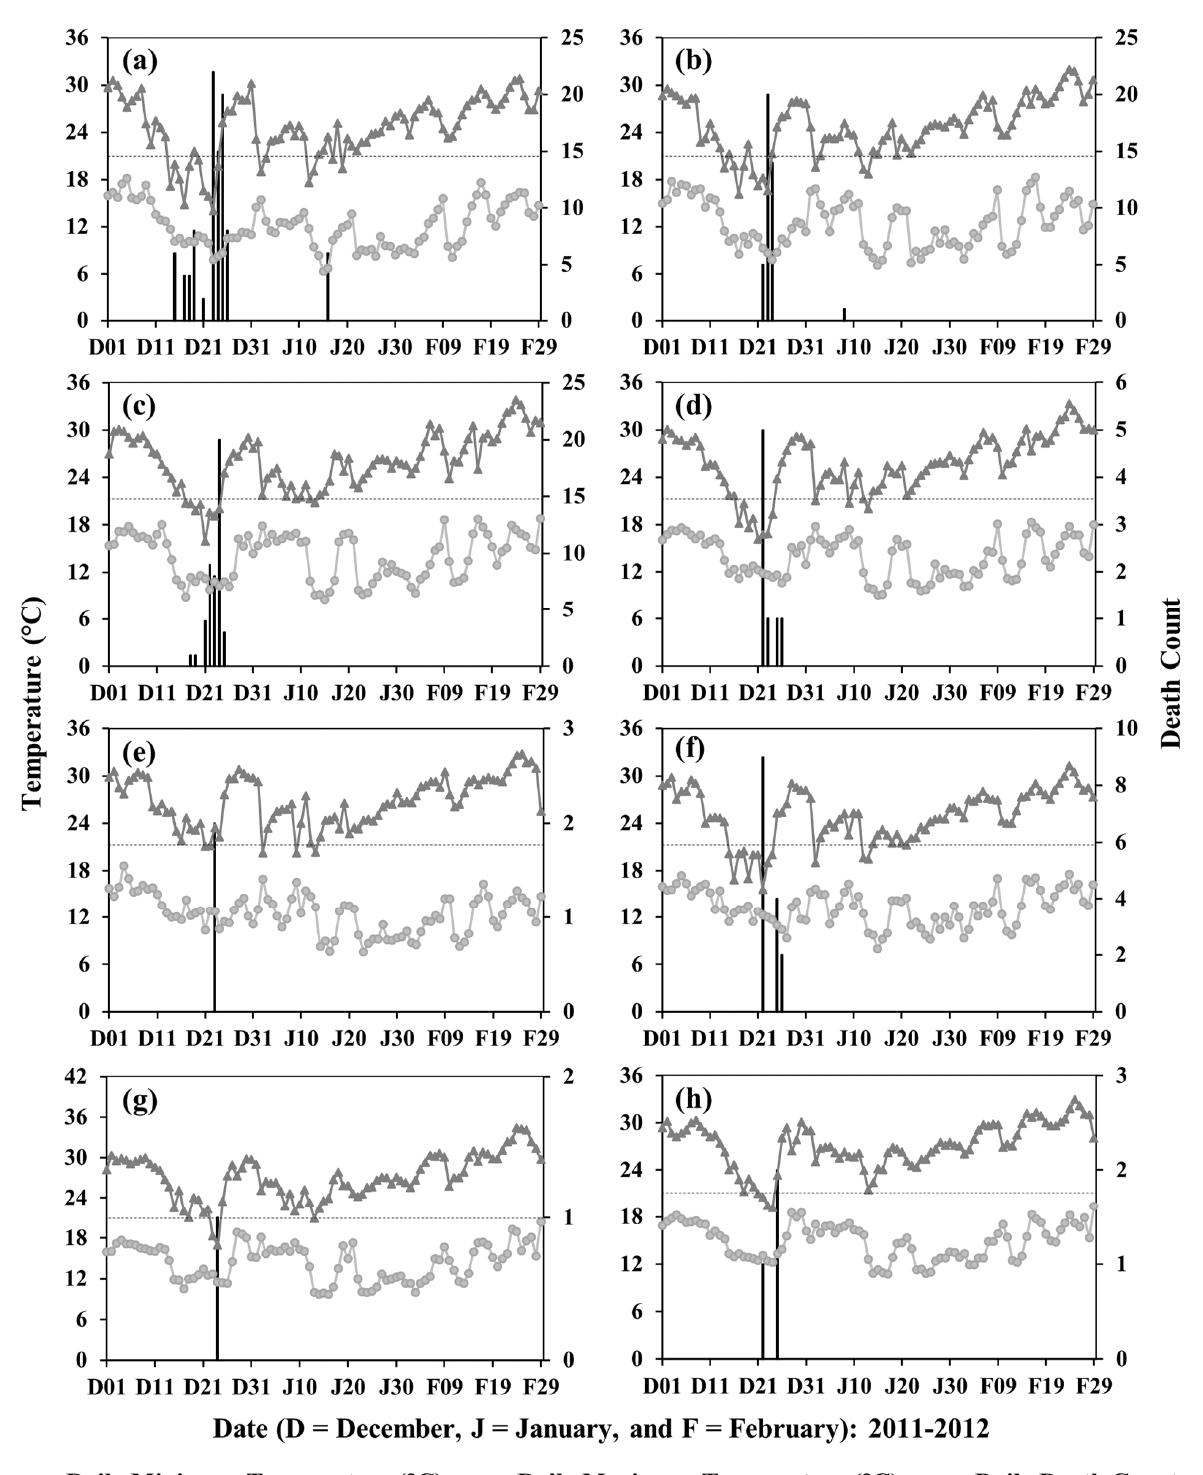
Figure 5. Relationship between cold-related deaths and winter temperatures for 2011–2012 in the divisions of ( a ) Rangpur, ( b ) Rajshahi, ( c ) Khulna, ( d ) Dhaka, ( e ) Sylhet, ( f ) Mymensingh, ( g ) Barishal, and ( h ) Chattogram. Horizontal dotted lines represent moderate cold at 21 °C.